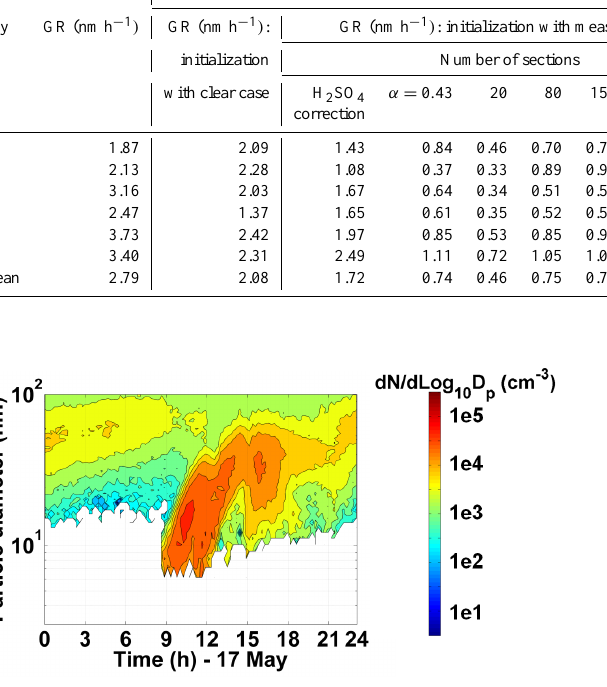
Fig. 7. Contour plot showing the particle number size distribu- tion [cm − 3 ], expressed as d N /dLog D p , measured on 17 May. The presence of a closed contour line around the highest particle num- ber concentrations may imply non-local nucleation (Birmili and Wiedensohler,